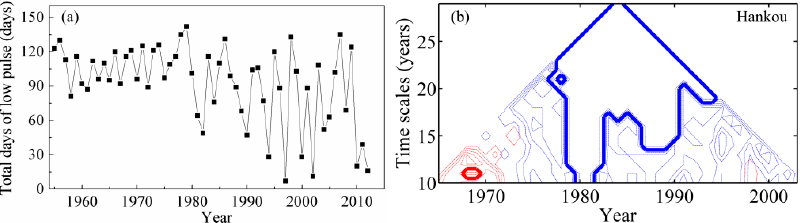
Figure 11. Changes in total days of low pulses at the Hankou station: ( a ) annual values; ( b ) abrupt behaviors.